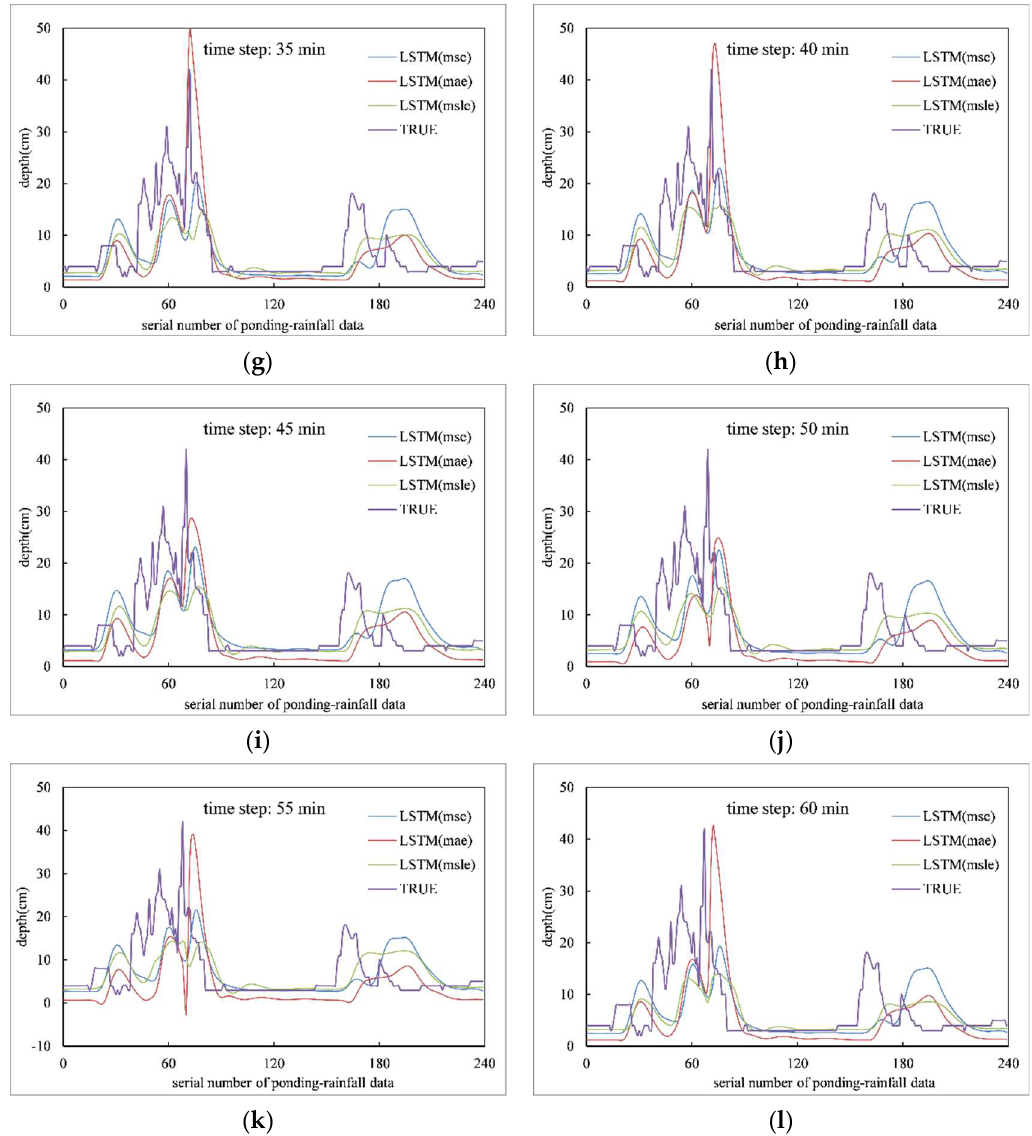
Figure 3. Predicted results of water depth at each time-step ( a – l ) are the prediction results of 5 min, 10 min, 15 min, 20 min, 25 min, 30 min, 35 min, 40 min, 45 min, 50 min, 55 min and 60 min.